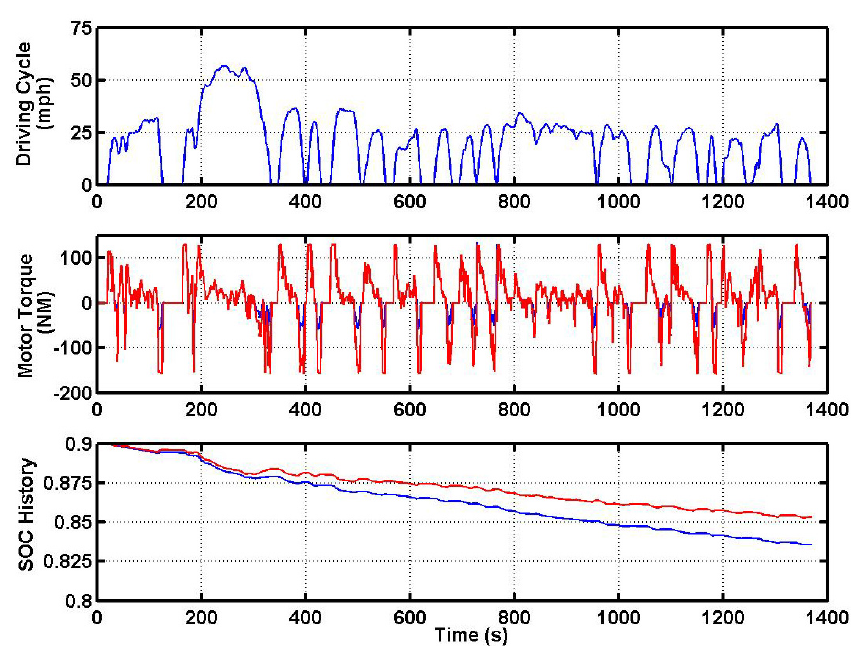
Figure 14. Simulation results under UDDC